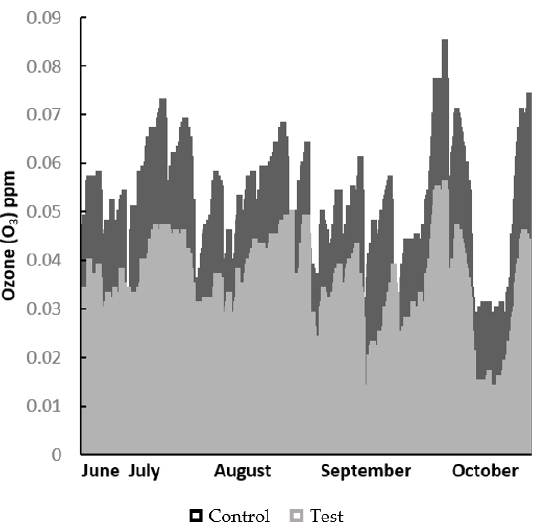
Figure 3. Difference (ppm) between test and control sites for ozone (O 3 ), June to October 2017. There was an observed reduction in ozone across all sites and applications of green infrastructure, with an average of 0.02 ppm (Figure 4) representing an average reduction of 34 percent resulting from the application of agricultural green infrastructure (Figure 3).